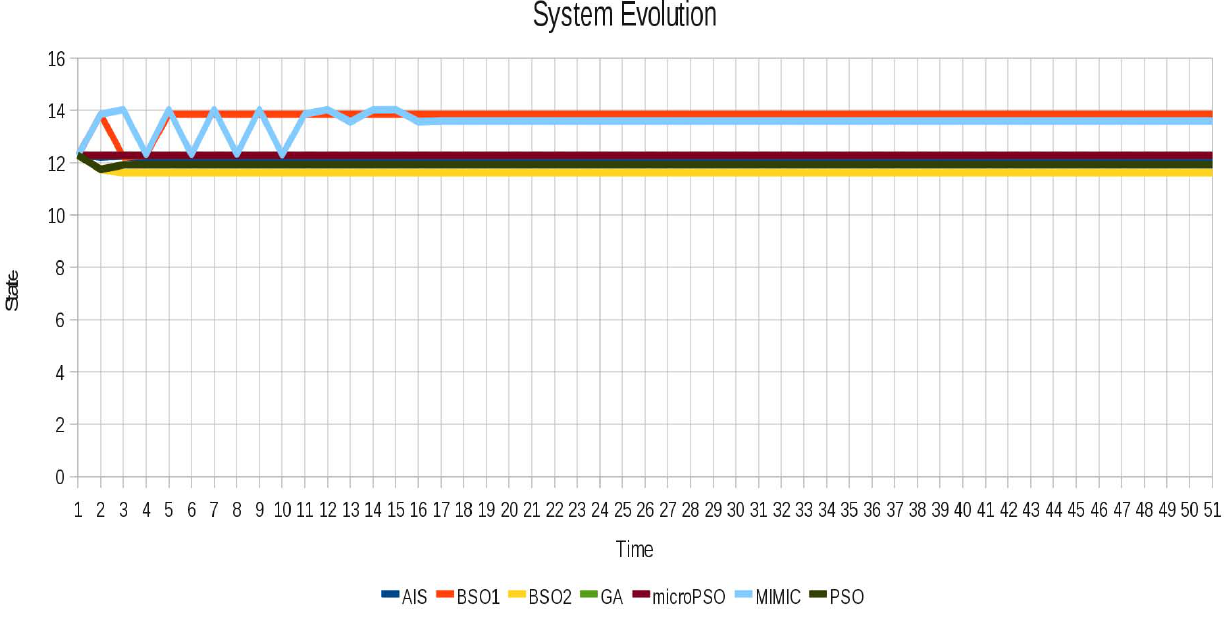
As for instance 3 (Toad), the oscillatory behavior shown in Figure 10 looks very similar to instance 1